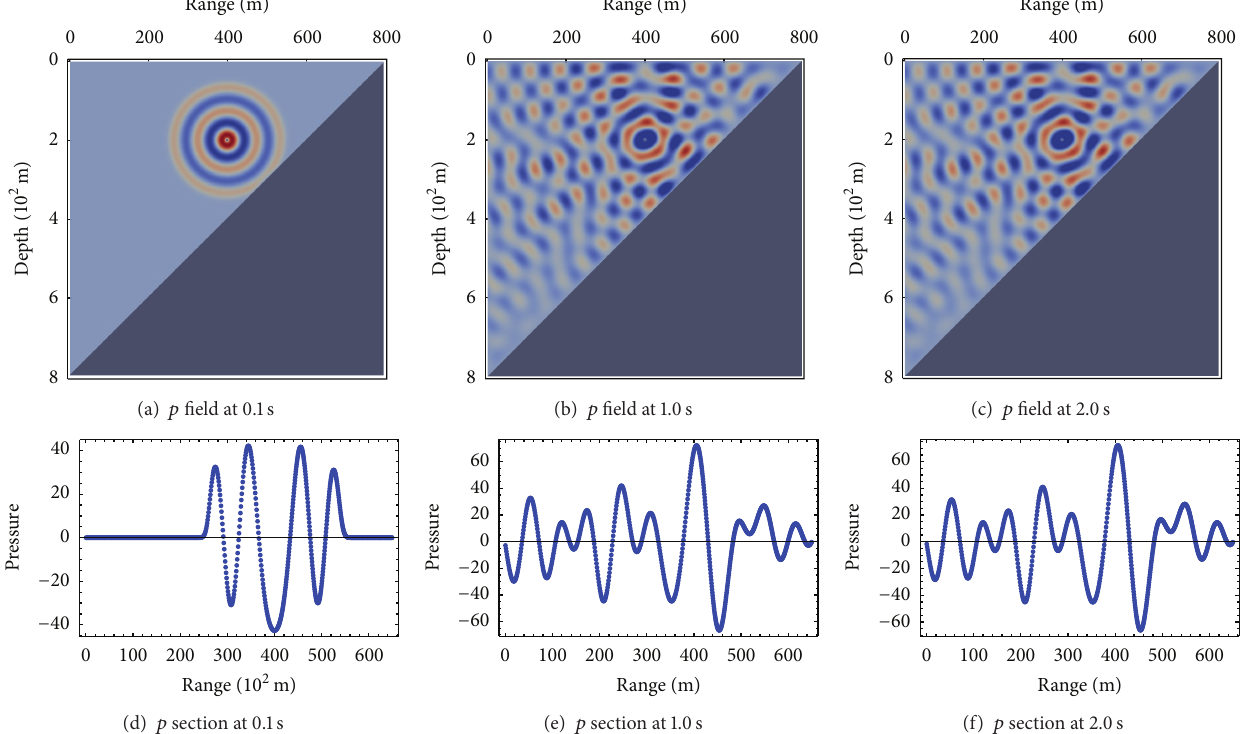
Figure 5: The overview of the pressure field 𝑝 of the pressure-release bottom problem at time 0.1 s and 1.0s and the spatial section of the pressure field 𝑝 at depth of 150 m: (a) and (d) show the snapshot at 𝑡 = 0.1 s; (b) and (e) show the snapshot at 𝑡 = 1.0 s; (c) and (f) show the snapshot at 𝑡 = 2.0